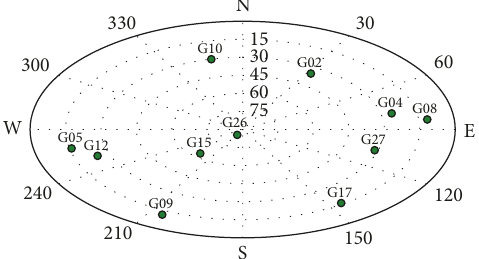
Figure 3: Geometry of satellites in the test.